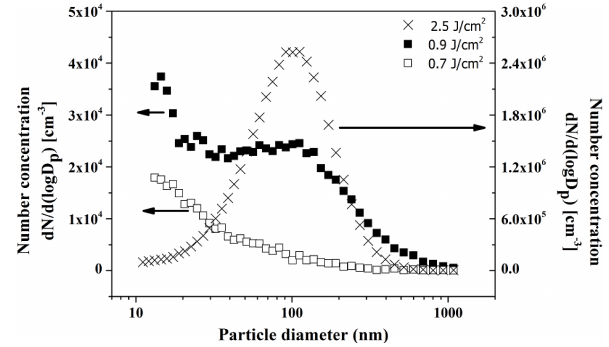
Figure 3. Number size distribution of the generated carbonaceous particles at three different laser fluences. Note: the right y axis ap- plies for the 2.5Jcm − 2 fluence.